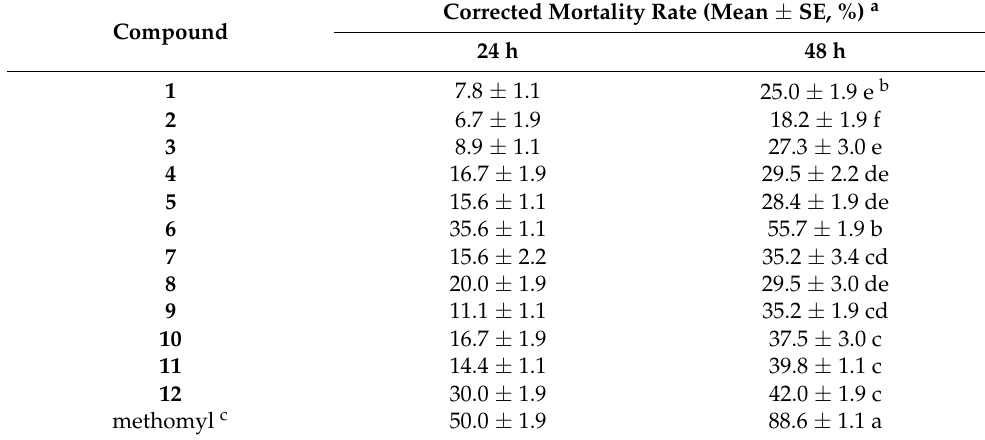
Table 4. LD 50 values of compounds 1 and 6 against A. citricola at 48 h.